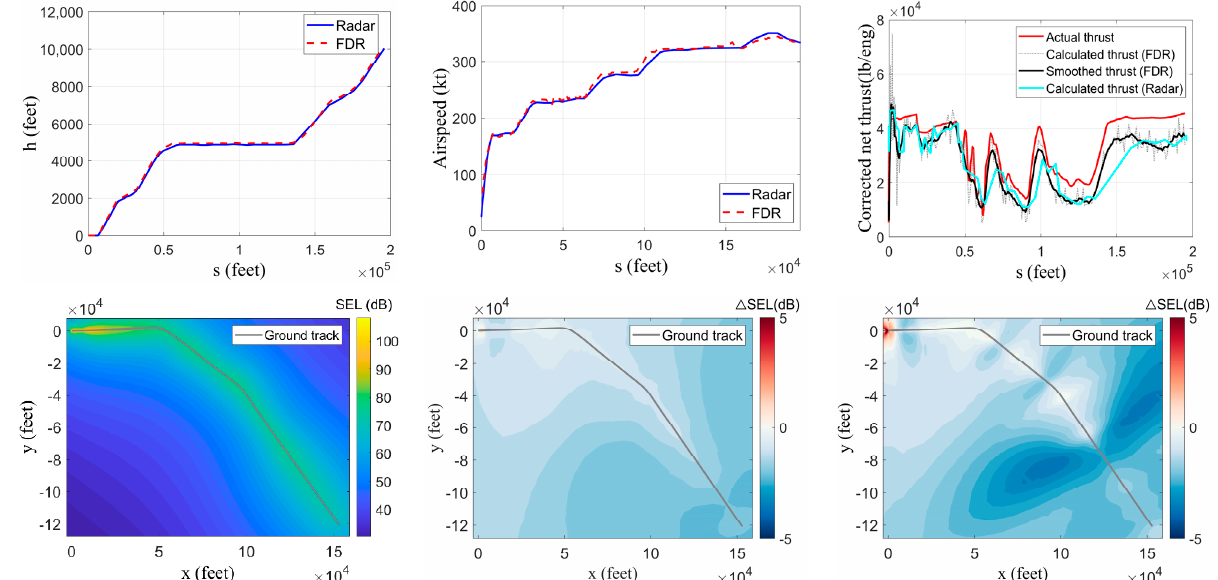
Figure 29. A330 aircraft departing from HKIA (flight AD8). Top: Comparison between the flight profile (left), airspeed (center), calculated and actual thrust (right) inferred from the FDR and radar data. Bottom: Noise contour map, as obtained using FDR data and actual thrust (left). Error entailed by an approximation of the thrust (center: smooth calculated thrust) plus the trajectory estimation (right: radar data, calculated thrust).